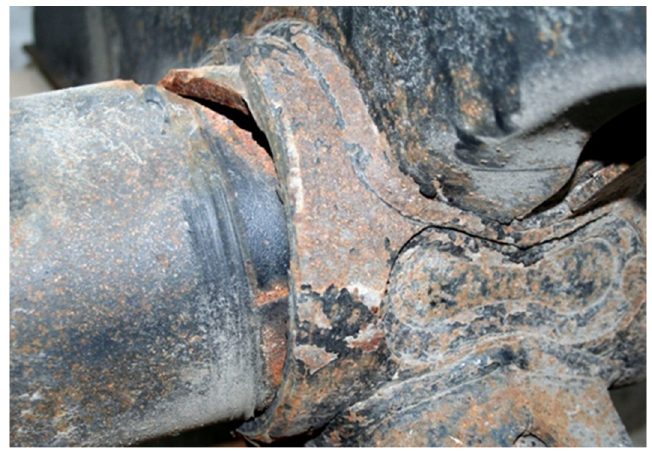
Figure 14. Axis fracture location.